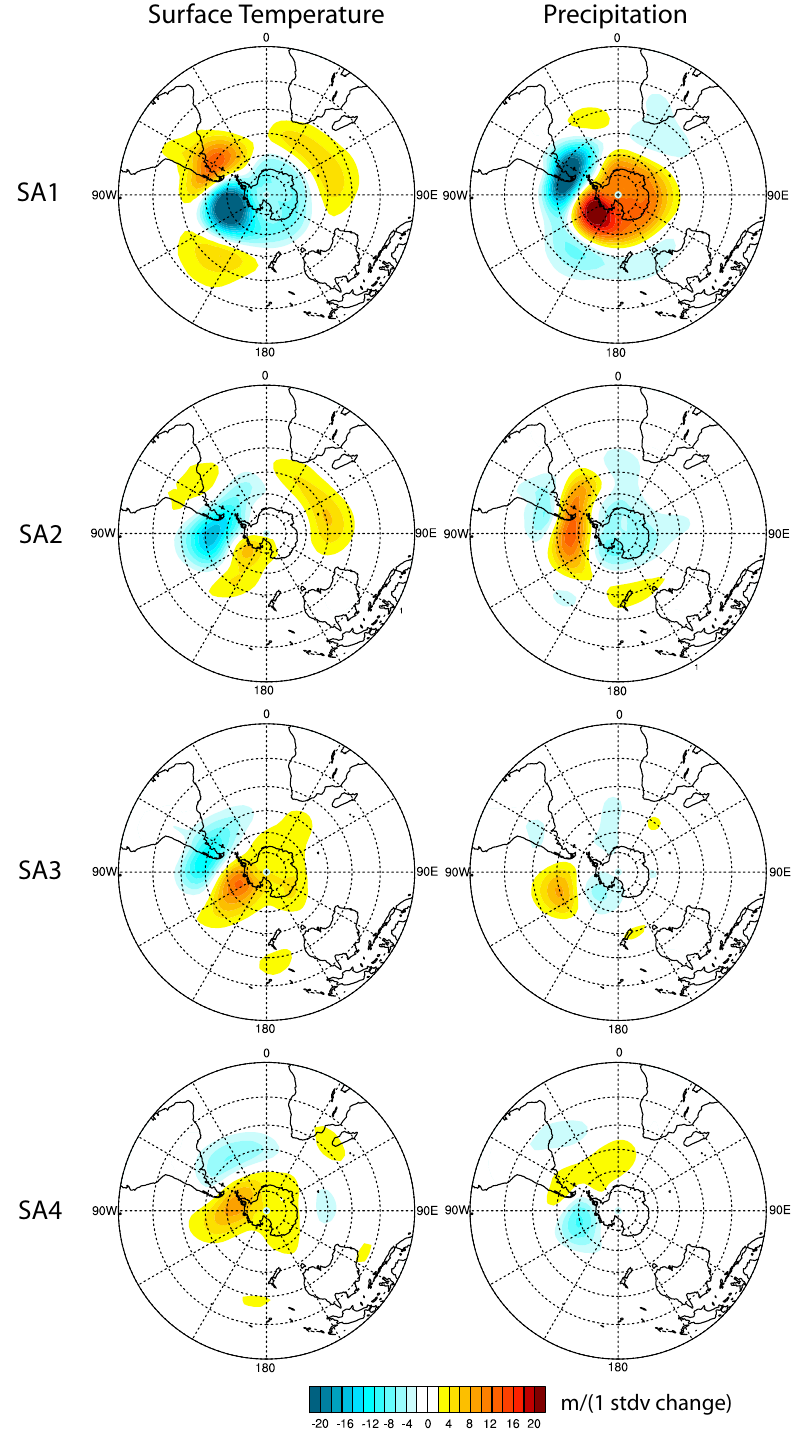
Fig. 7. Ensemble average regression coefficients between normalized regional surface temperature (left panel) and precipitation (right panel) anomalies and Z850. Units are m per one standard deviation change of temperature or precipitation, respectively.